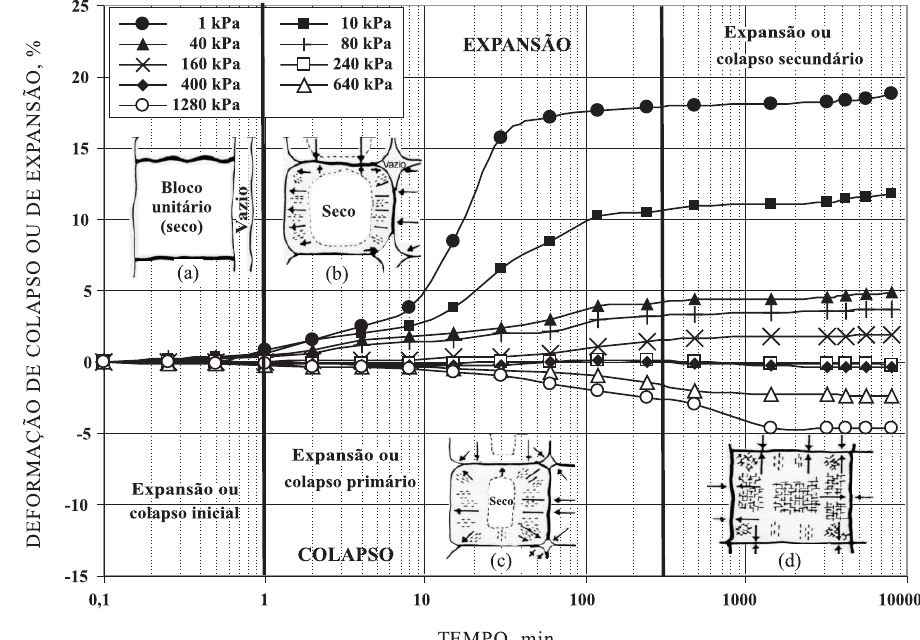
Figura 6. Comportamento de variação de deformação com o tempo sob tensão com avanço da frente de umedecimento: (a) há pequena alteração na umidade do solo; (b) há mudança de umidade na periferia do solo; (c) apenas o núcleo central mantém a umidade inicial; (d) há mudança de umidade em todo o